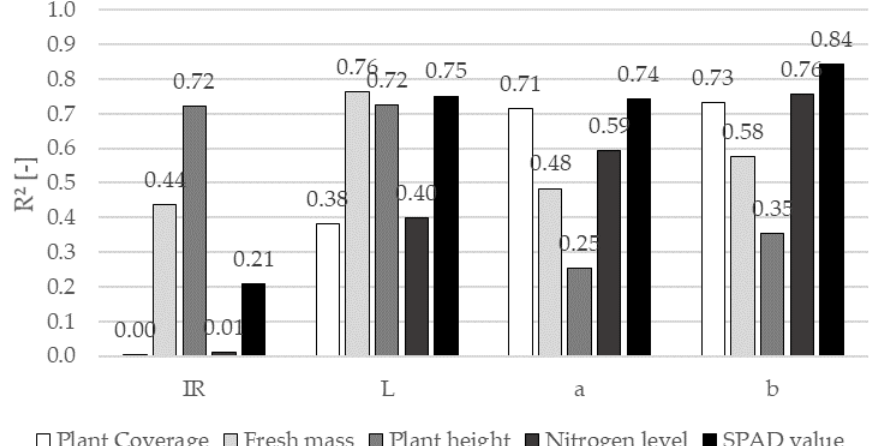
Figure 9. R 2 of the reflection channels with respect to plant coverage, fresh mass, plant height, nitrogen level and SPAD value, accumulated for the inquired growth stages.